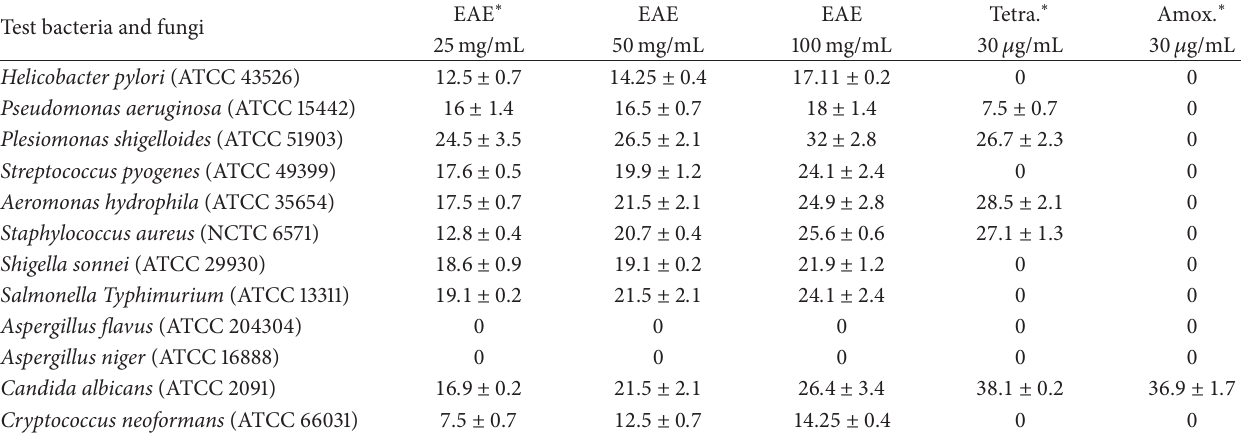
Table 2: Mechanism of antibiosis using MLC/MIC